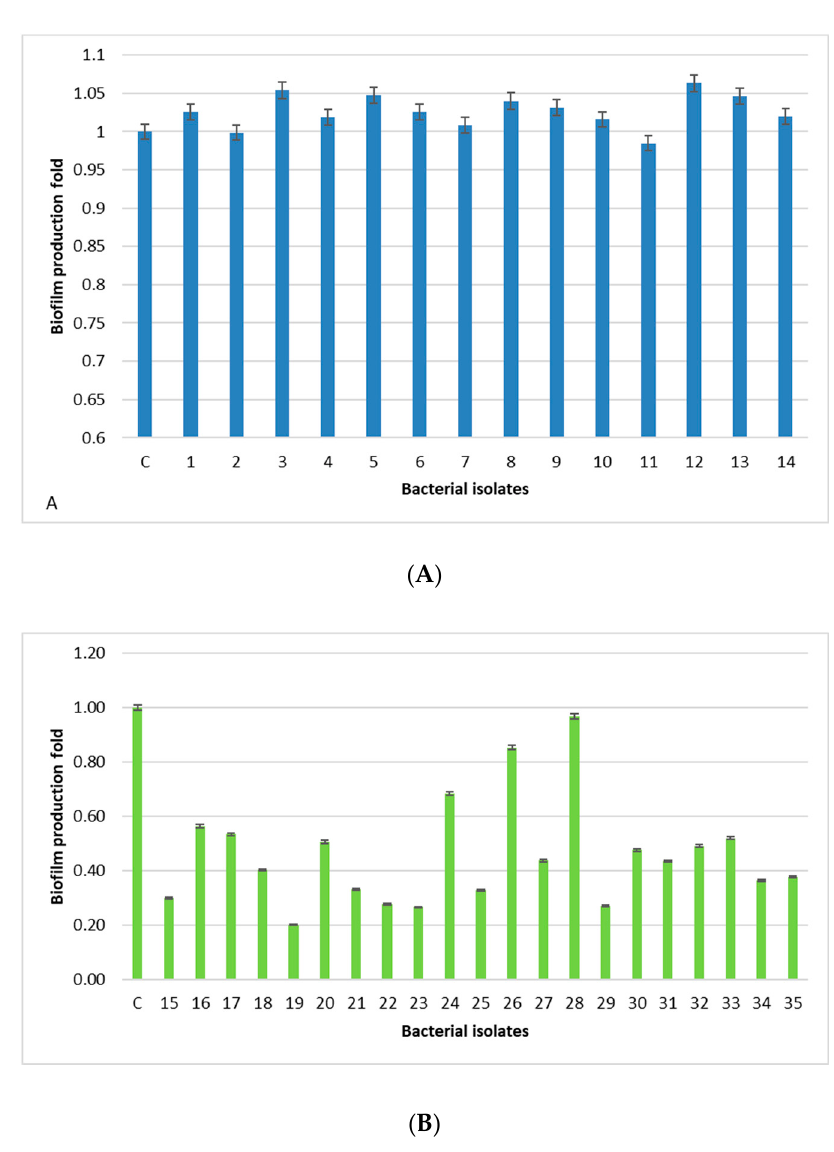
Figure 2. Biofilm production in human- ( A ) and animal-derived isolates ( B ). C represents the positive control. Standard deviations are indicated. Each experiment was performed in triplicate. Biofilm production was measured as the absorbance at 600 nm wavelength after crystal violet staining of the tubes containing the cultures.